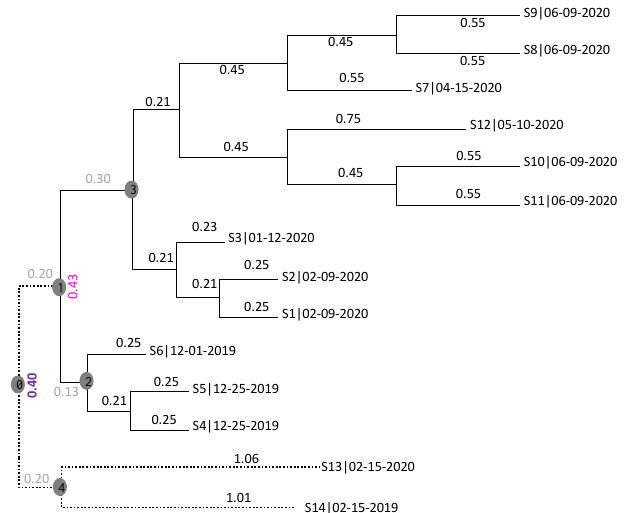
Figure 5. A fictitious viral tree with 14 viral genomes (S1 to S14) taken at different times shown as part of OTU names. Branch lengths are indicated next to the branch. An unrooted tree including S1 to S12 but excluding S13 and S14 would have only one branch connecting Node 2 and Node 3, with the branch length indicated by the pink 0.43. Similarly, an unrooted tree of all 14 samples has only one branch connecting Node 1 and Node 4, with the branch length indicated by the purple 0.40. Numbered circles are nodes mentioned in the text.